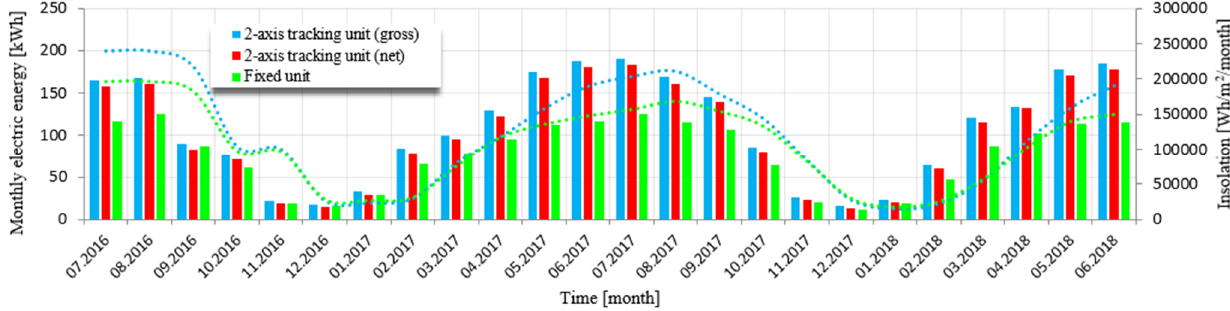
Figure 12. Variability of electricity produced by photovoltaic modules in the fixed and dual-axis tracking configurations for a two-year measuring period and insolation recorded on both planes.